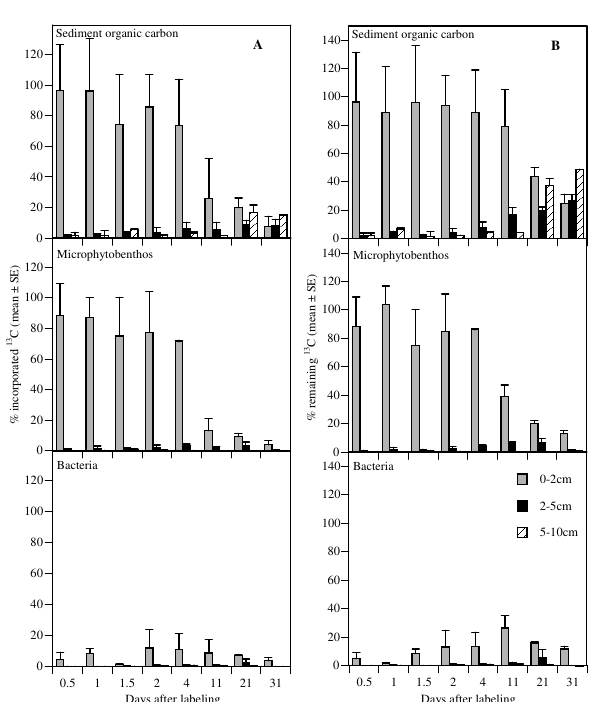
Fig. 2. Percentage (mean ± SE, n = 2) of the 13 C that was ini- tially incorporated by microphytobenthos (A) , and percentage (mean ± SE, n = 2) of the 13 C remaining within total sediment OC at each time (B) , that was found within total organic carbon, micro- phytobenthos, and bacteria in sediment at depths of 0–2cm, 2–5cm and 5–10cm throughout the study period. Days after labeling in- dicate time of sample collection, including time required for core